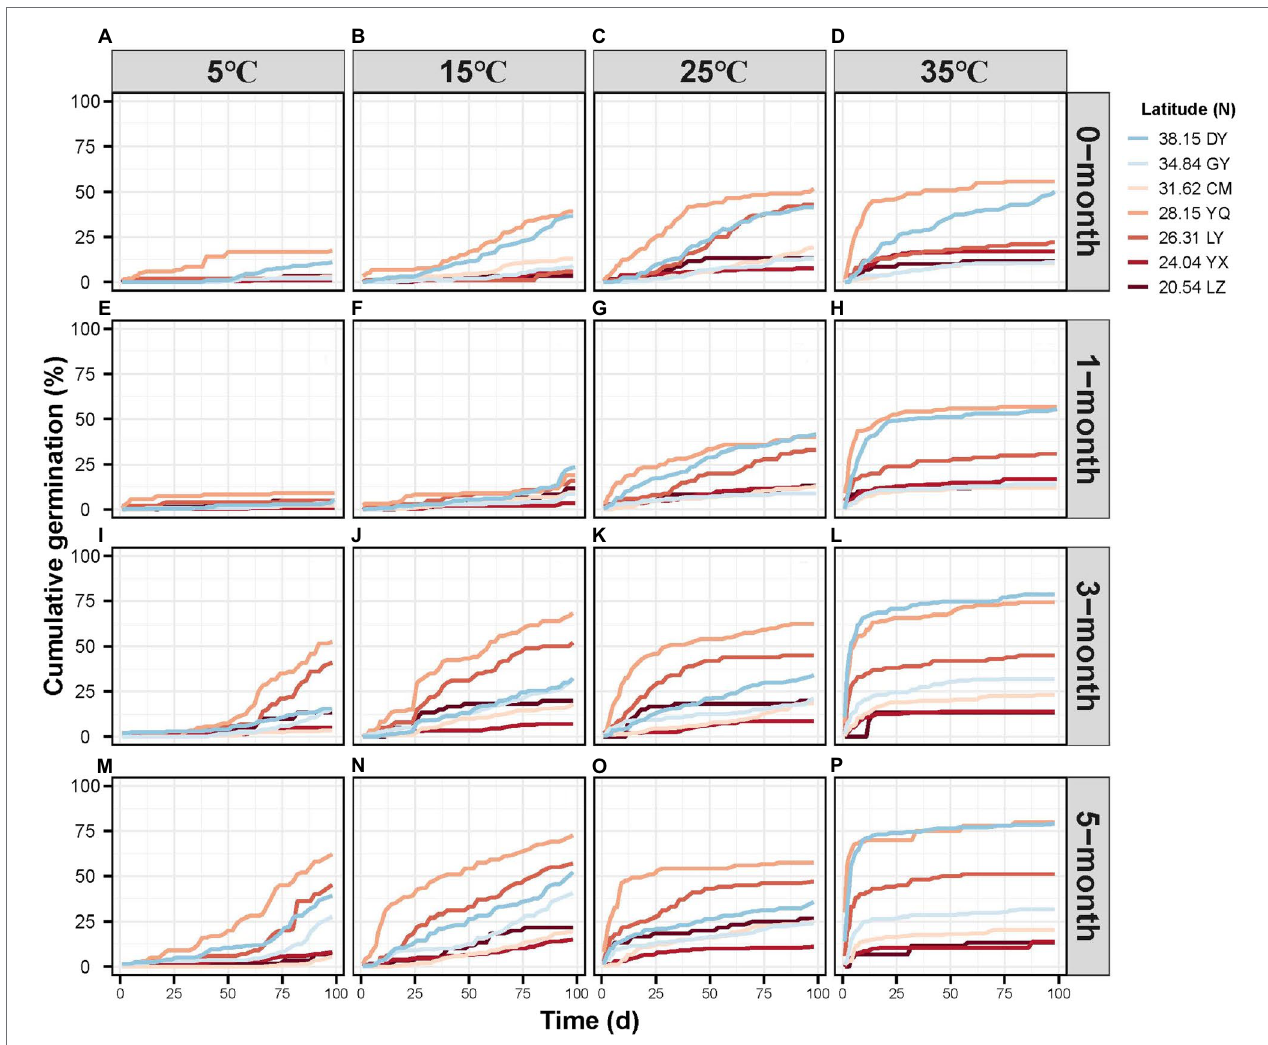
FIGURE 2 | The cumulative germination percentage per observation day of different latitude sites under different stratification time ( A-D 0-month; E-H 1-month; I-L 3-month; M-P 5-month) and temperature ( A, E, I, M 5 °C ; B, F, J, N 15 °C ; C, G, K , O 25 °C ; D, H, L, P 35 °C